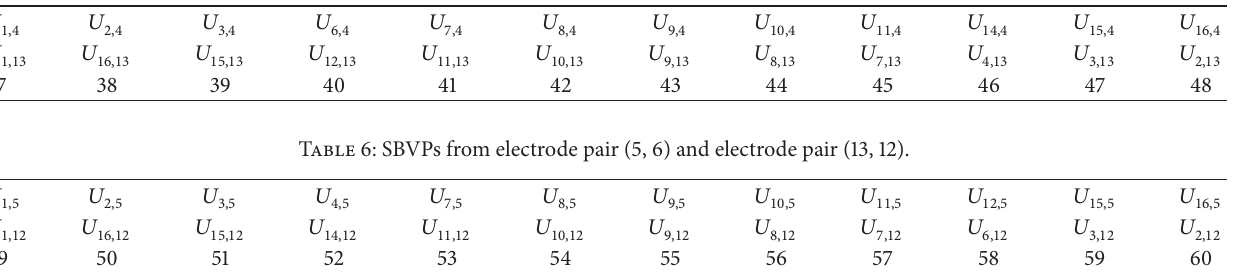
Table 5: SBVPs from electrode pair (4, 5) and electrode pair (14, 13).